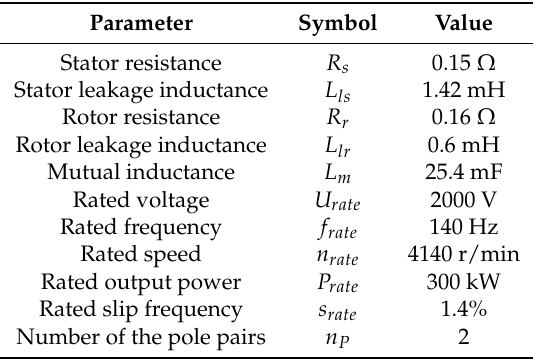
Table 5. Parameters of traction